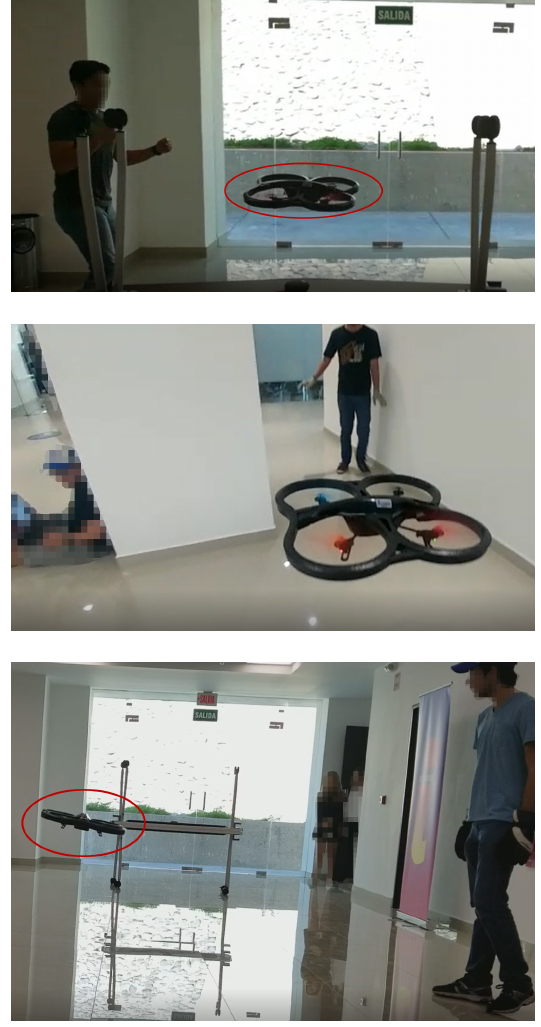
Figure 2. Some scenes in which the students are testing the ARDRONE